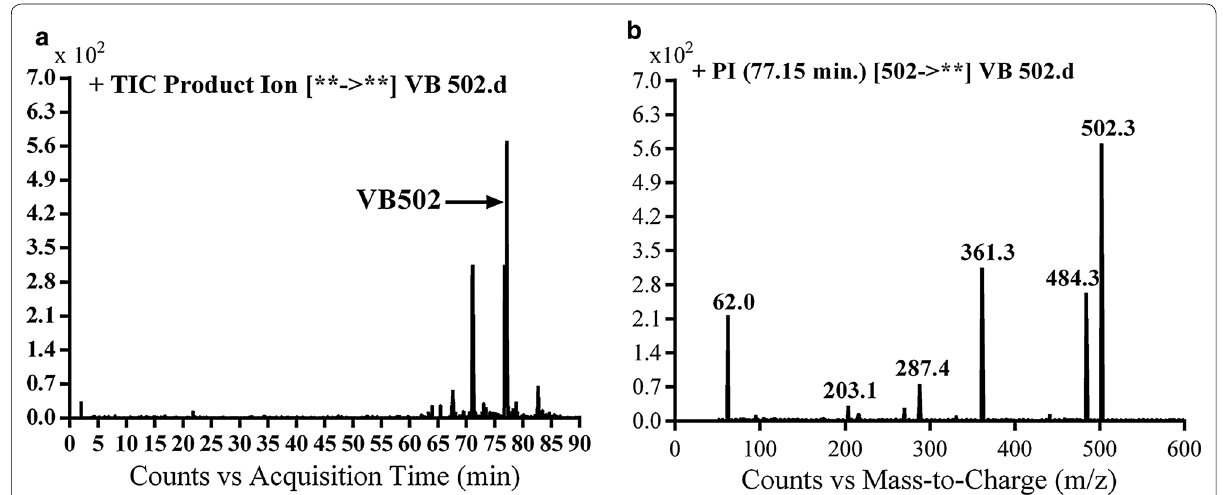
Fig. 7 PI chromatogram of MIP at m/z 502 showing one peak (VB502) at 77.1 min ( a ), PI mass spectrum of VB502 ( b